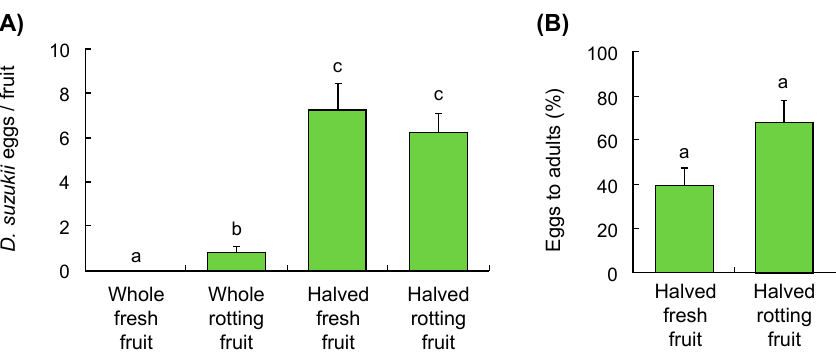
Figure 3. ( A ) Oviposition by D. suzukii on harvested citrus with different conditions and ( B ) percentage of eggs that developed to adults. Bars refer to mean ± SE, and different letters over the bars indicate significant difference (One-way ANOVA and Tukey’s HSD, p < 0.05).